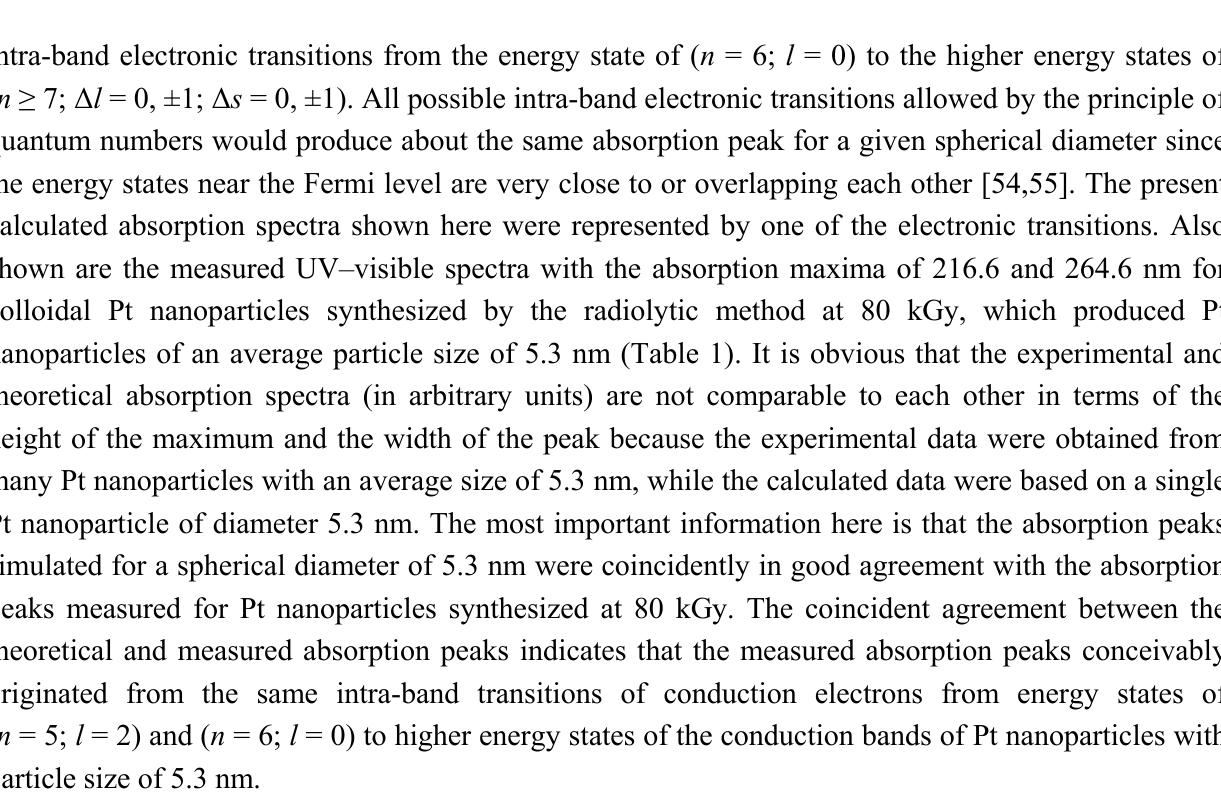
Figure 6. Absorption spectra with absorption maxima of 217.1 and 265.1 nm calculated